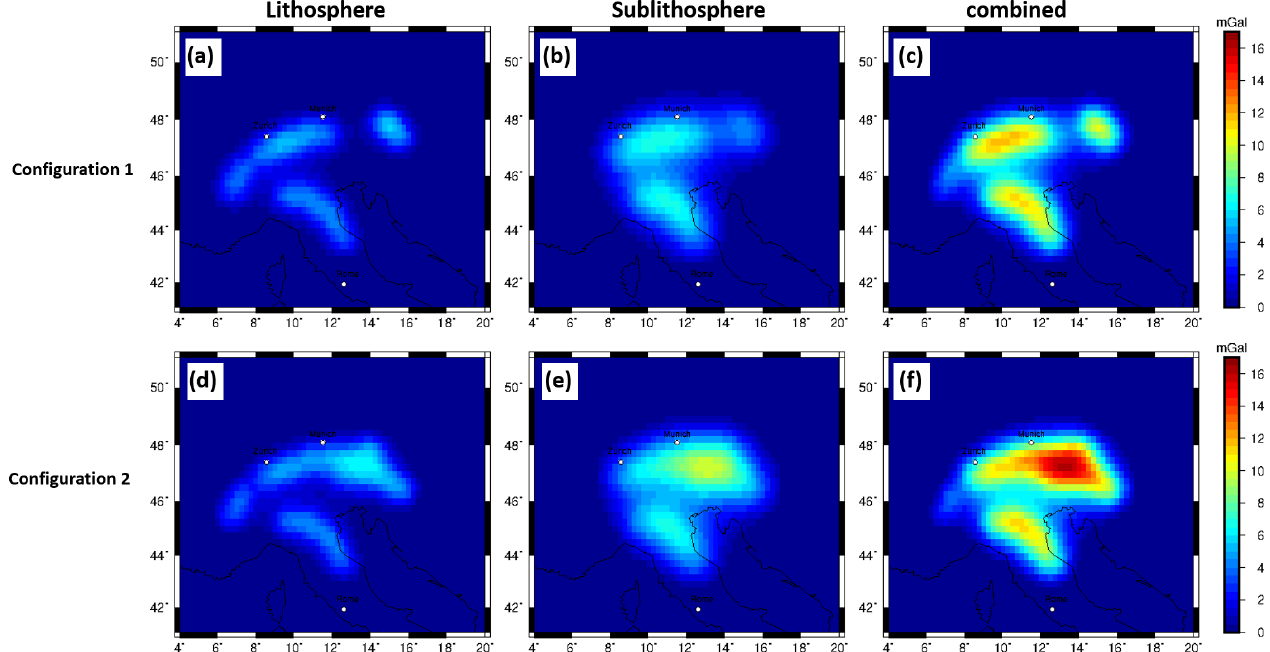
Figure 11. Residual of the forward-calculated gz gravity signal of lithospheric slabs at surface station height based on LitMod models with Tecton-like compositions in the lithosphere and PUM and DMM compositions in the sublithosphere ( M 1 , M 2 , M 3 , M 4 ) with an additional thermal anomaly of − 100K for the sublithospheric slab segment, for predefined slab configurations to the background model ( M 0 ). (a– c) Configuration 1. (d–f) Configuration 2. Crustal and topographic contribution are